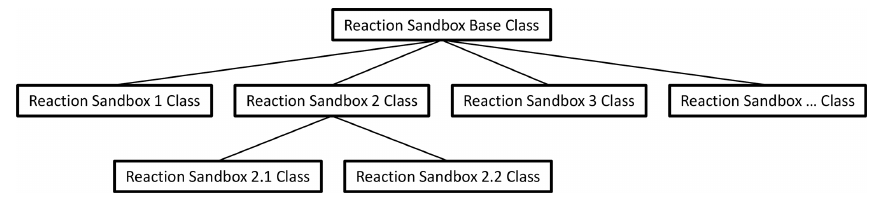
Figure 1. Schematic of a hypothetical Reaction Sandbox class hierarchy.